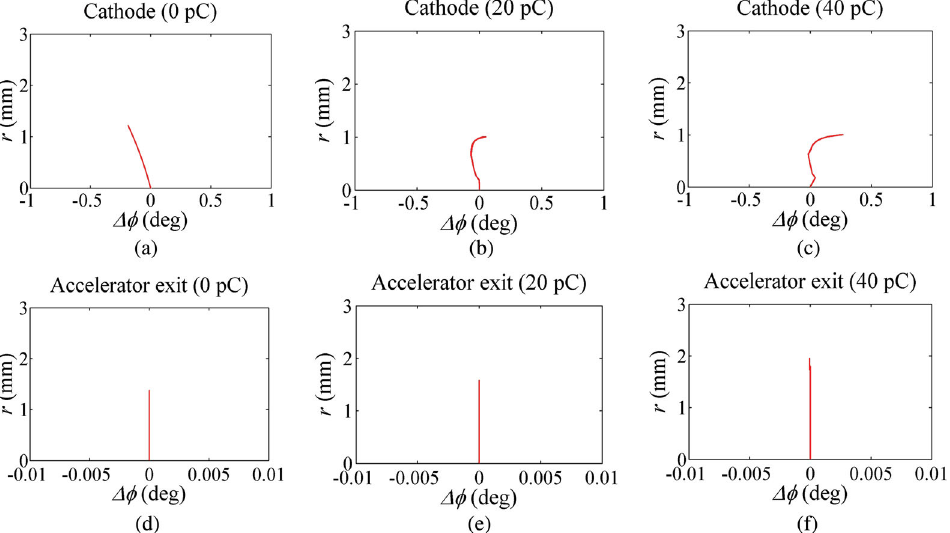
FIG. 8. Δ ϕ − r distributions of electron bunches with flattop transverse profiles at the cathode for total charges of 0, 20, and 40 pC (a) – (c) before and (d) – (f) after acceleration, respectively. The injection phase of the reference particle for this simulation study is ϕ 190 °. With IPC, the distribution of the electron bunch at the exit of the accelerator is fully restored to a delta 0 ¼